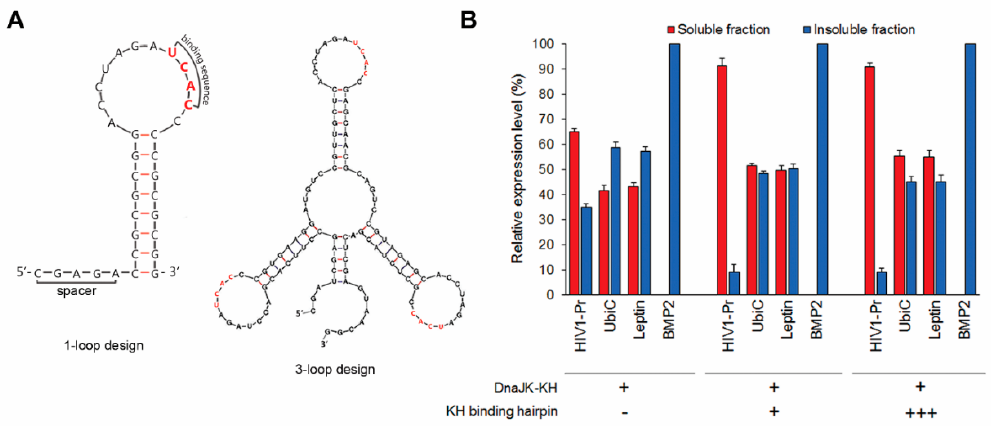
Figure 2. Combinatorial effect of increasing 3 ′ UTR KH hairpin number and employing the chimeric chaperone fusion DnaJ-DnaK-KH (DnaJK-KH) on solubilizing four recombinant proteins, HIV1-Pr, UbiC, leptin, and Adh1p. ( A ) Sequence designs for constructing the 1-loop and 3-loop KH hairpin in the target protein mRNA 3 ′ UTRs using RNA Designer and mFold. The spacer described in 1-loop design is a sequence between the stop codon of a gene encoding a target protein and the 3 ′ UTR hairpin, varied from 5- to 30-nt. ( B ) The solubility of the four recombinant proteins that were not solubilized using the CRAS system with DnaJ-KH as the main chaperone, utilizing a chimeric DnaJK-KH chaperone including one (+) or three (+++) 3 ′ UTR sequences downstream of the target gene coding sequence. Soluble protein quantification was conducted using ImageJ v1.48 software on Coomassie Blue-stained SDS-PAGE images. Error bars represent ± S.D. from three independent experiments.